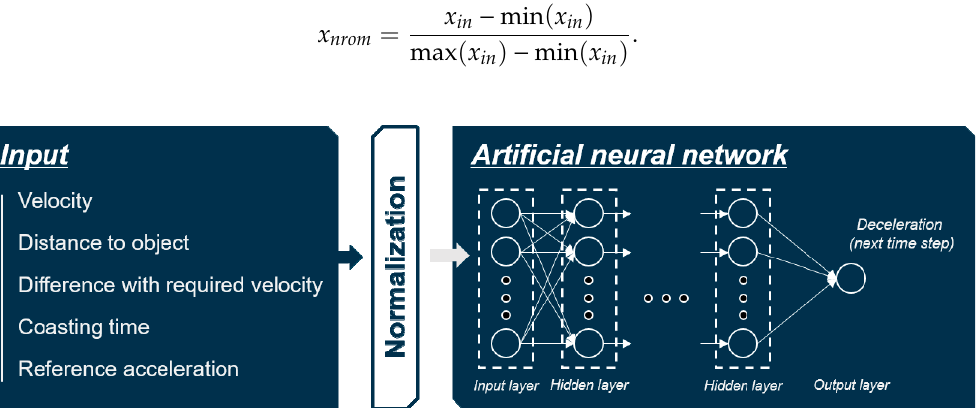
Figure 5. Overall structure of the multi-layer perceptron (MLP) model.